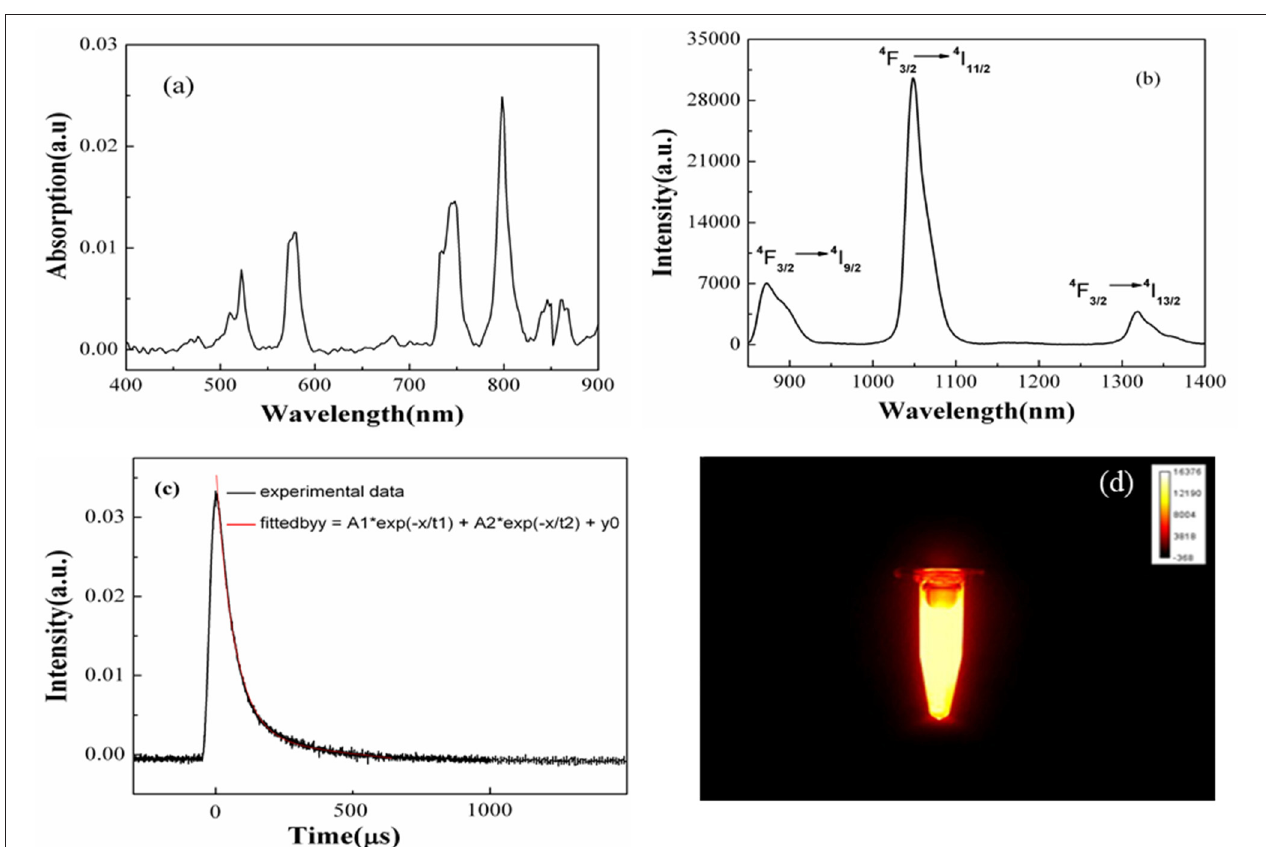
FIGURE 3 | Absorption spectrum (a) , emission spectrum (b) , decay curve (c) , and NIR image (d) of the BaF 2 :Nd NP dispersion in DMSO-d6/propanetriol solvents (10 mg/mL).